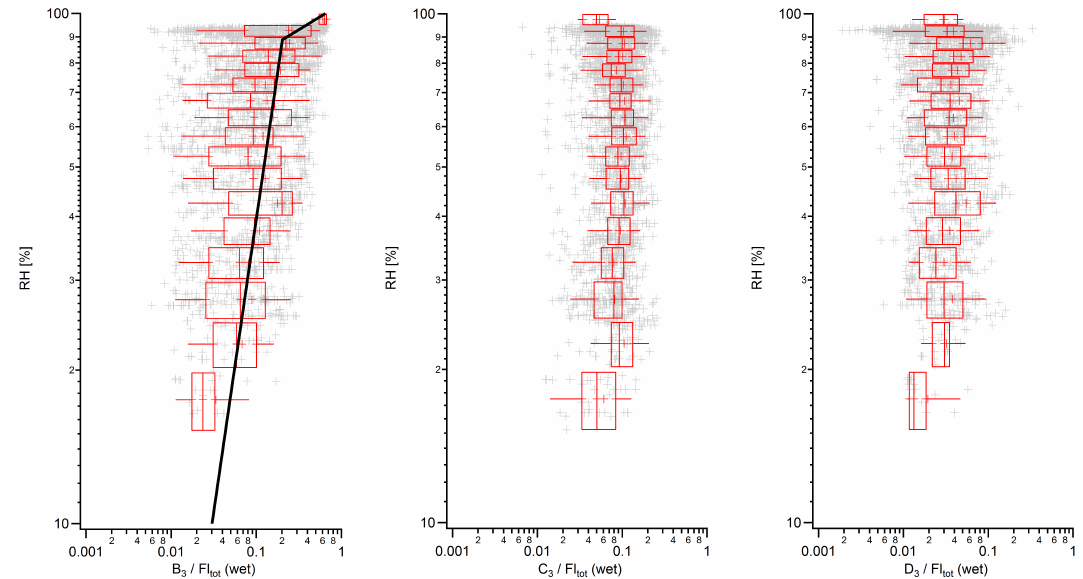
Figure 12. As for Fig. 11 but for wet conditions. A linear fit in log–log space has been added to B 3 (see Eq. 4). Norm of residuals: Fig. 12. As for Fig. 11 but for wet conditions. 5th order polynomial fit added to cluster B 3 . Fig. 12. As for Fig. 11 but for wet conditions. A linear fit in log-log space has been added to B 3 (see B 3 / Fl tot ( wet, RH < 88 . 8%)=0.34; B 3 / Fl tot ( wet, RH ≥ 88 . 8%)=0.14. ( wet, RH < 88 . 8 % ) = 0 . 34; B /F l ( wet, RH 88 . 8 % ) = 0 . 14 . Eq. 4). Norm of residuals: B 3 /F l 3 tot tot ≥